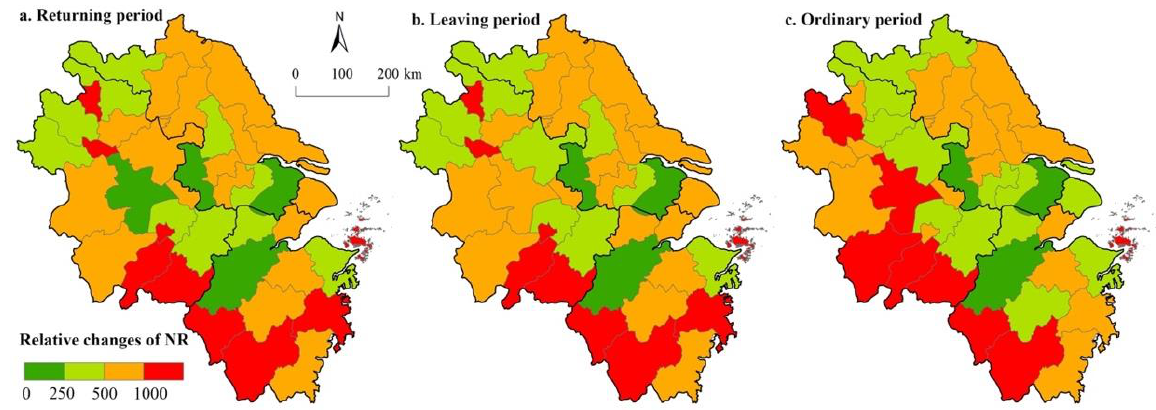
Figure 8. Spatial pattern of attenuation in node resilience.